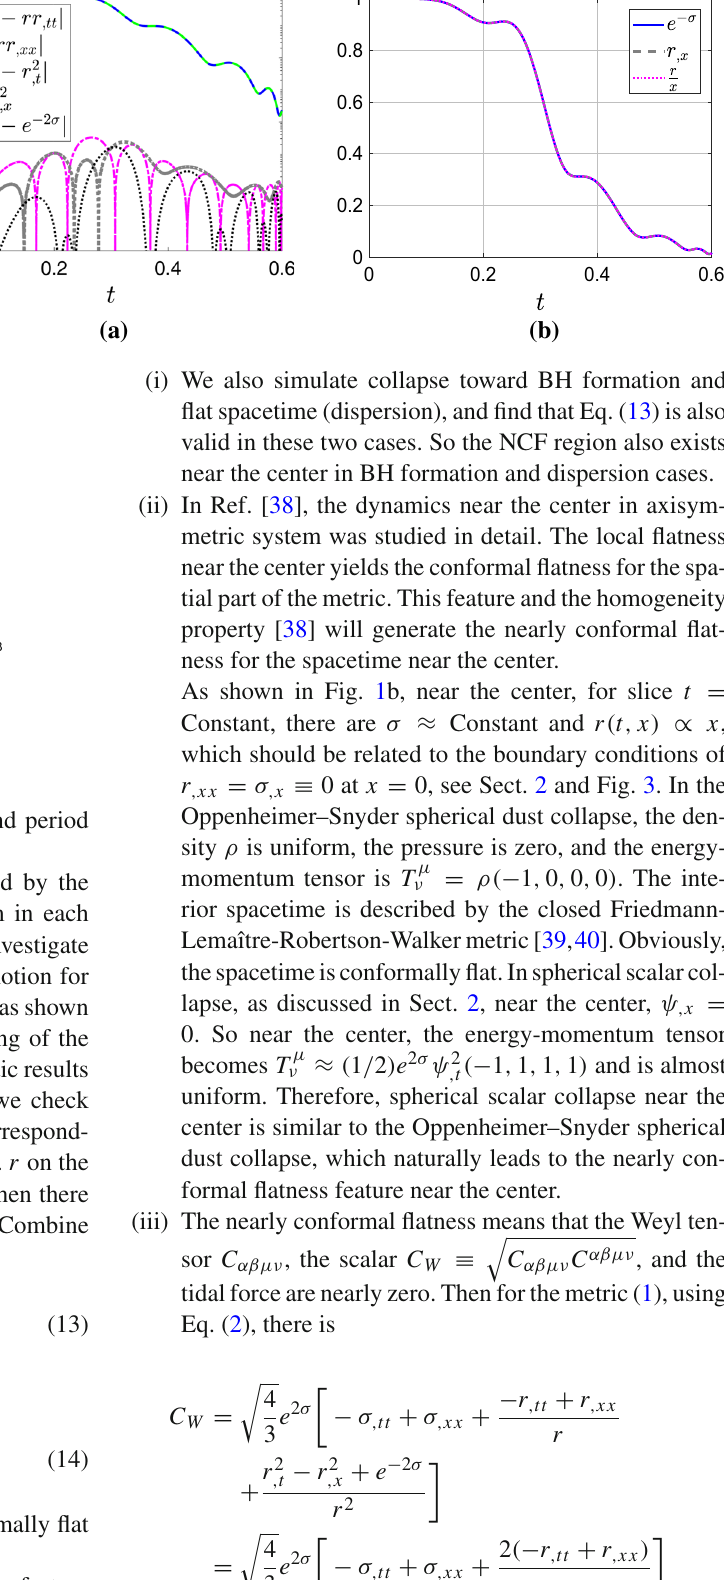
Fig. 2 Contributions of all the terms in the equation of motion for r (2). a e − σ ≈ r , x . b